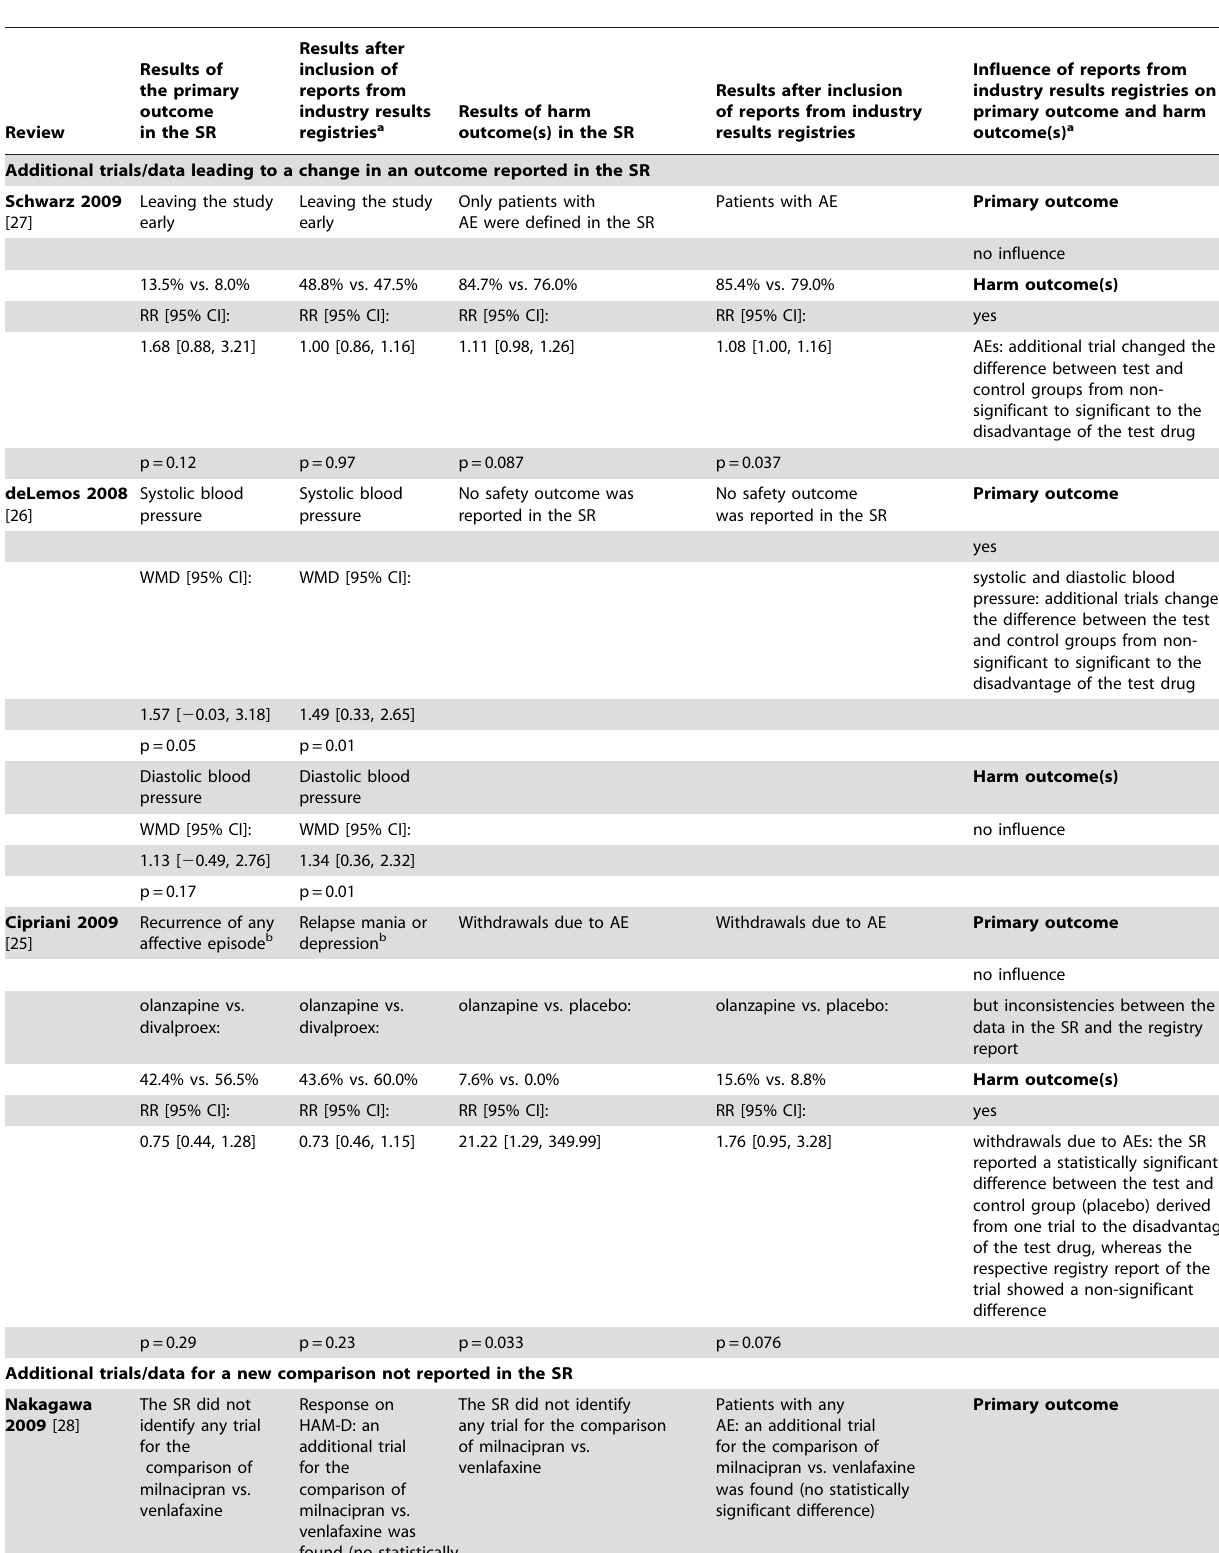
Table 3. Systematic reviews where a search in industry results registries led to a change in results: statistical details of results and influence on